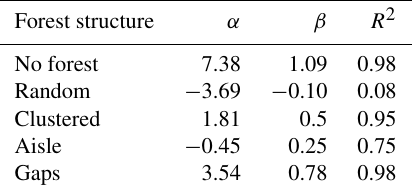
Table 6. α and β coefficient and adjusted R 2 with least-squares fitted power laws of the non-cumulative frequency–intensity distri- butions at a distance of 300m from the release area for forest type 1 with different horizontal forest structures and without